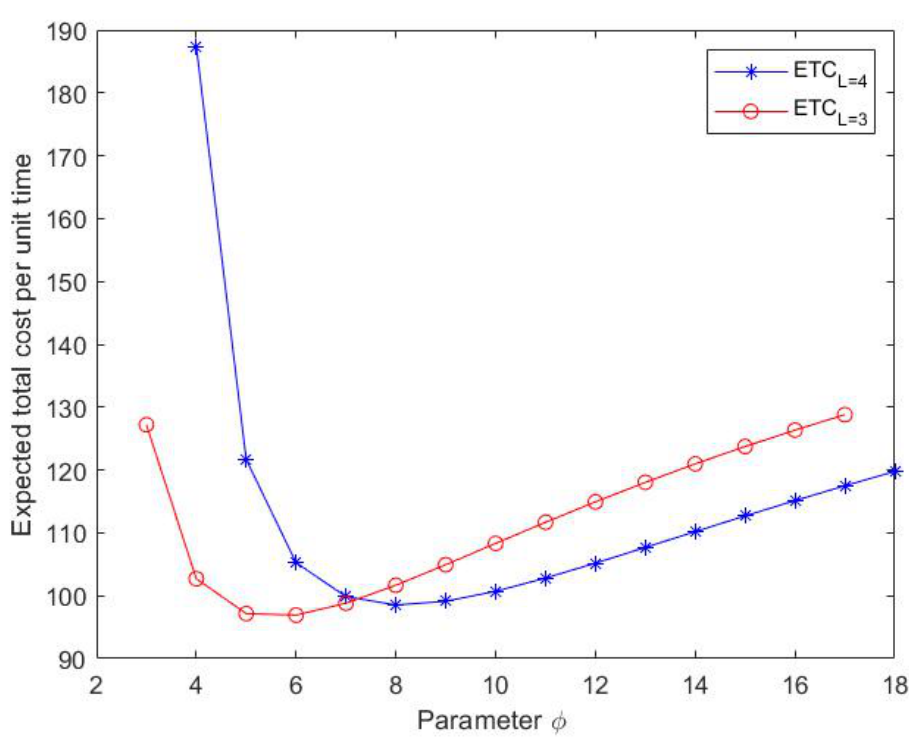
Figure 14. Effect of φ on the expected total cost